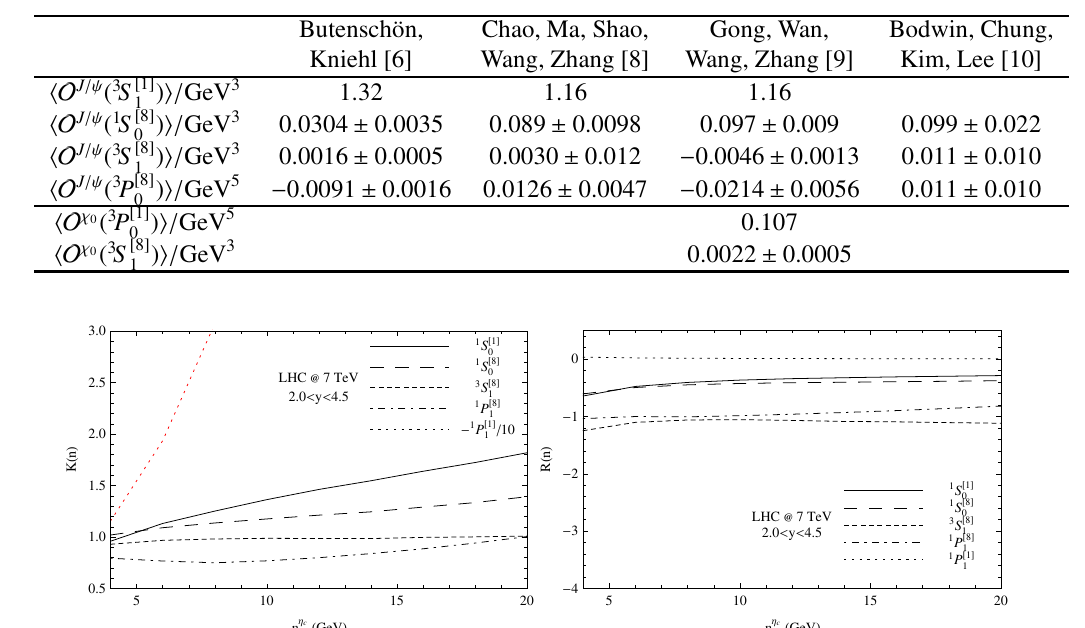
( α s ) corrections to the SDCs as functions of p η c O